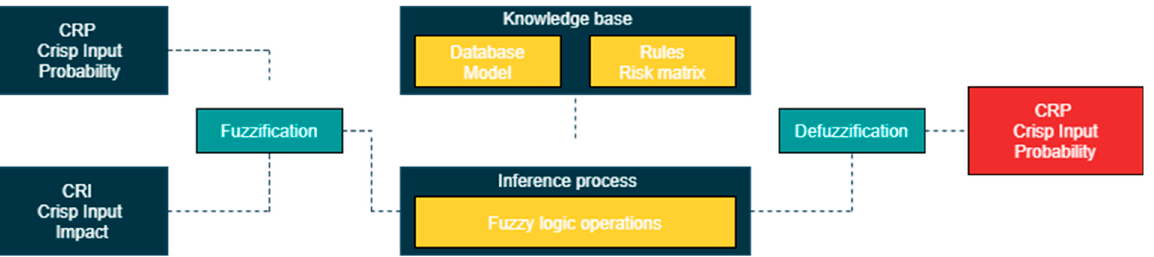
Figure 2. Fuzzy inference system [17].